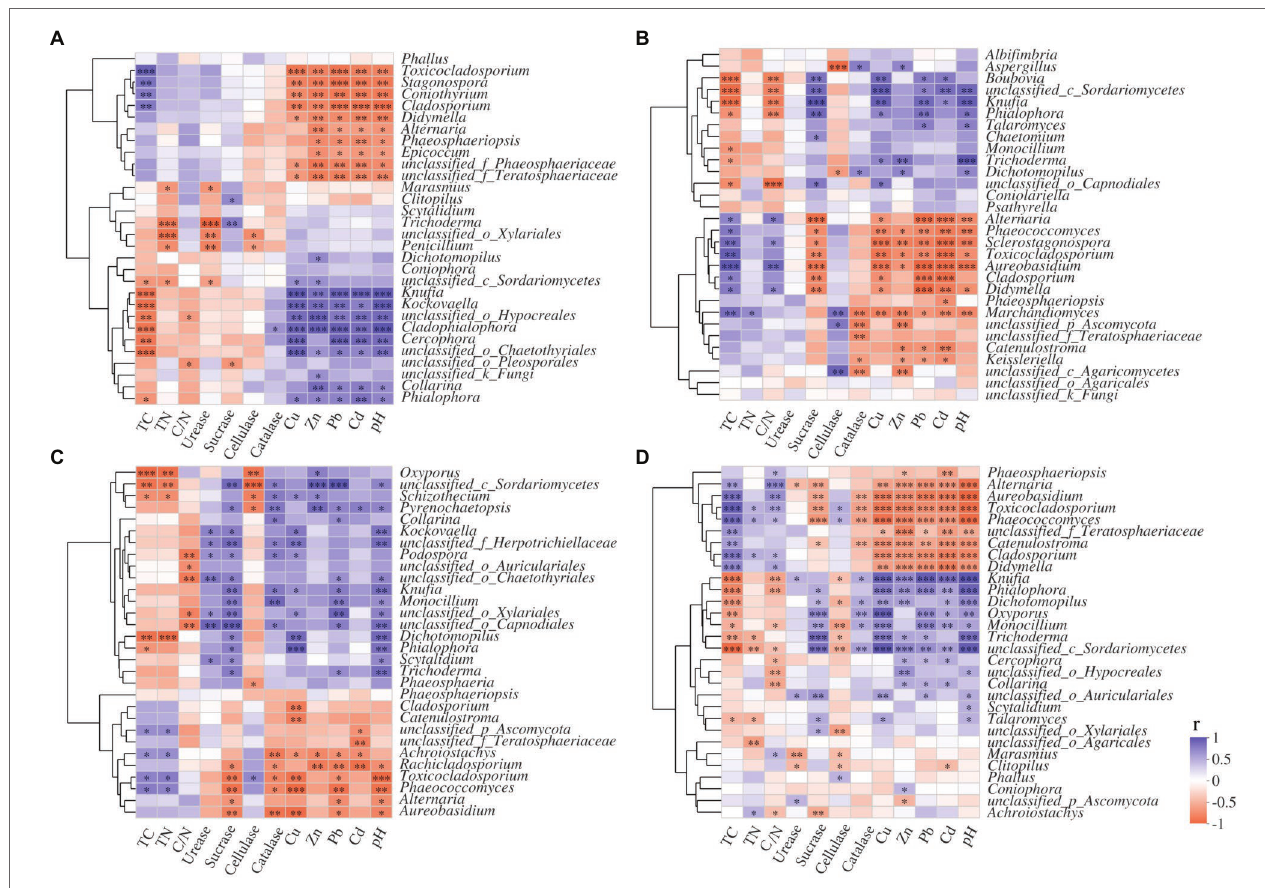
FIGURE 8 | Correlation analysis of litter properties and dominant fungi genera in S516 (A) , S536 (B) , S560 (C) , and the whole copper mining area (D) . Different colors denoted the relative coefficients. Significance levels were denoted with ** p < 0.01 and *** p <